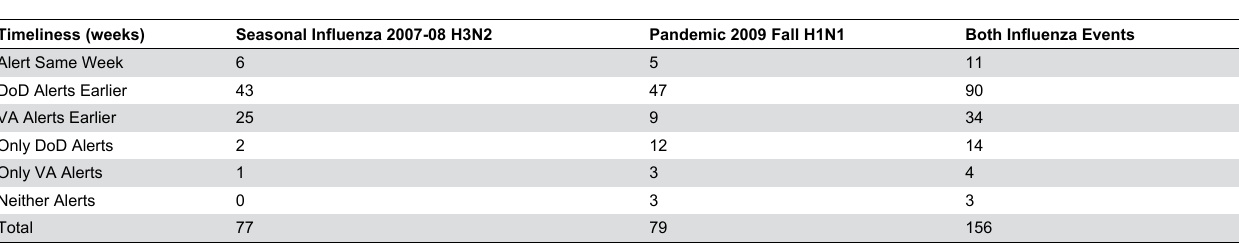
Table 1. Alerting timeliness comparison of Department of Defense (DoD) and Veterans Affairs (VA) outpatient records associated with influenza-like illness (ILI) during two different influenza events and both events combined for Core-Based Statistical Areas (CBSAs) that have both DoD and VA facilities and have at least 2 ILI patients/week stratified by alerting timeliness.